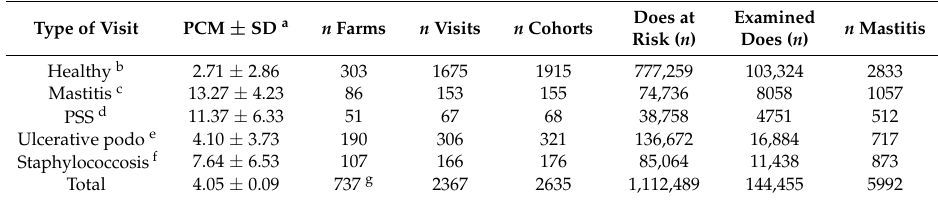
Table 2. Prevalence of clinical mastitis and diseases other than mastitis in 2635 cohorts of rabbit does physically examined on 490 farms in Spain and 41 farms Portugal from 2001 to